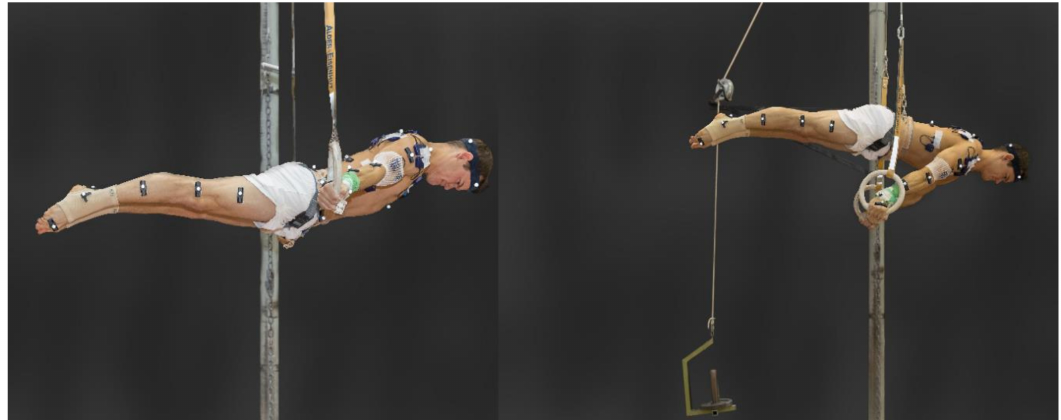
Figure 3. Test conditions for static exercises. The swallow ( left ) and support scale ( right ) exercises were performed with maximum resistance for five seconds. These examples show the use of additional weight ( left ) and the pulley and counterweight ( right